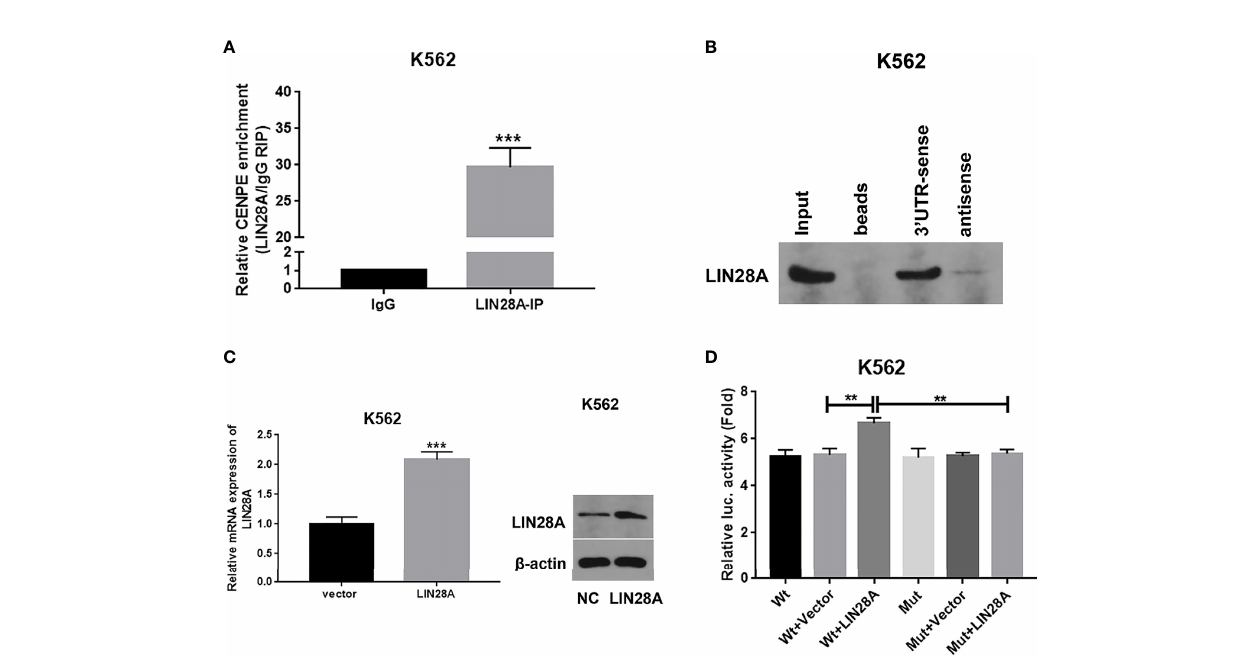
FIGURE 7 | LIN28A interacted with CENPE by binding to the 3 ’ UTR region. (A) CENPE mRNA enriched by IgG or LIN28A antibodies in K562 cells were detected by RIP-conjugated RT-qPCR. (B) RNA pull-down and Western blot assays were conducted to detect the LIN28A protein levels being pulled down by biotin sense or antisense CENPE 3 ’ UTR. (C) K562 cells were transfected with empty vector or LIN28A overexpression plasmid, and LIN28 expression was detected by RT-qPCR and Western blot. (D) The CENPE Wt and CENPE Mut were transfected in K562 cells, including CENPE Wt+Vector, CENPE Wt+LIN28A, CENPE Mut+Vector, and CENPE Mut+LIN28A, and 48 h after cell transfection, changes in luciferase activity were measured with a luciferase activity assay kit. ** p < 0.01. *** p < 0.001.